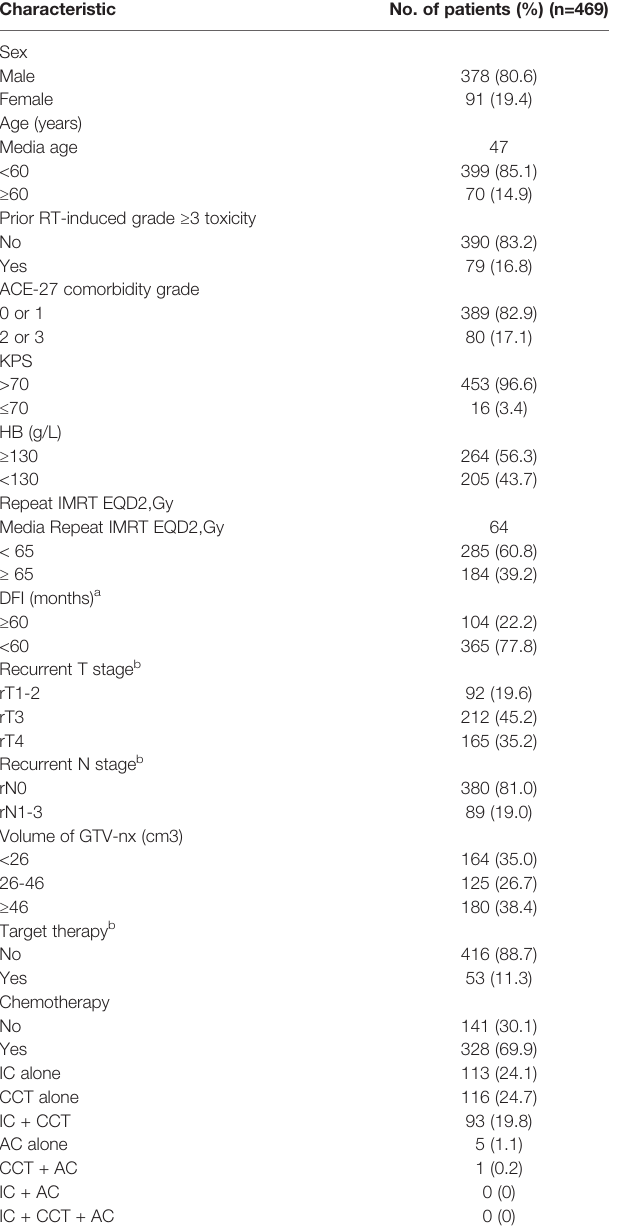
TABLE 1 | Clinical characteristics of 469 patients with locally recurrent nasopharyngeal carcinoma. Characteristic